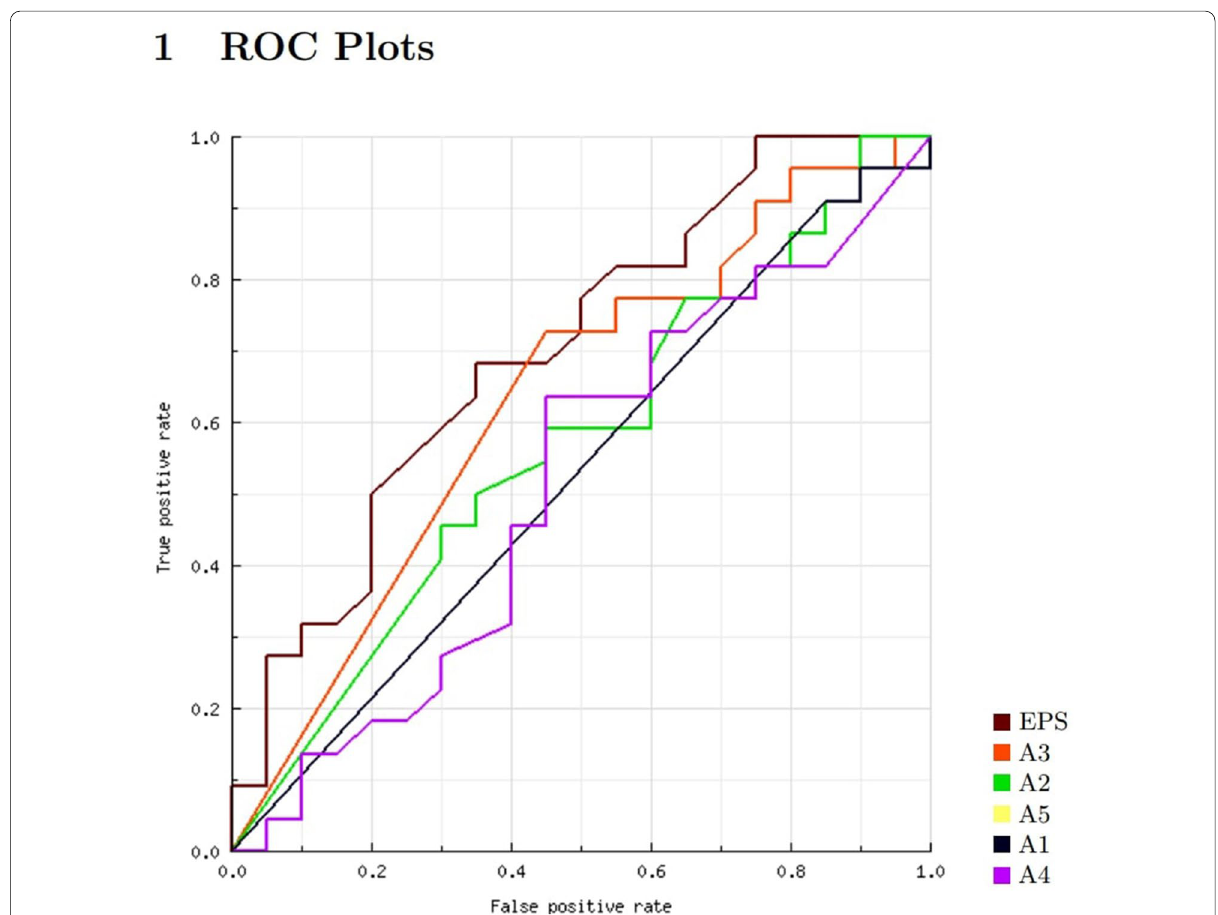
Fig. 4 Receiver operating characteristic (ROC) curve analysis regarding the predictive value of 3D electroanatomical origin (EPS) and the five ECG algorithms for differentiating (A1–A5) when assessment was performed by the